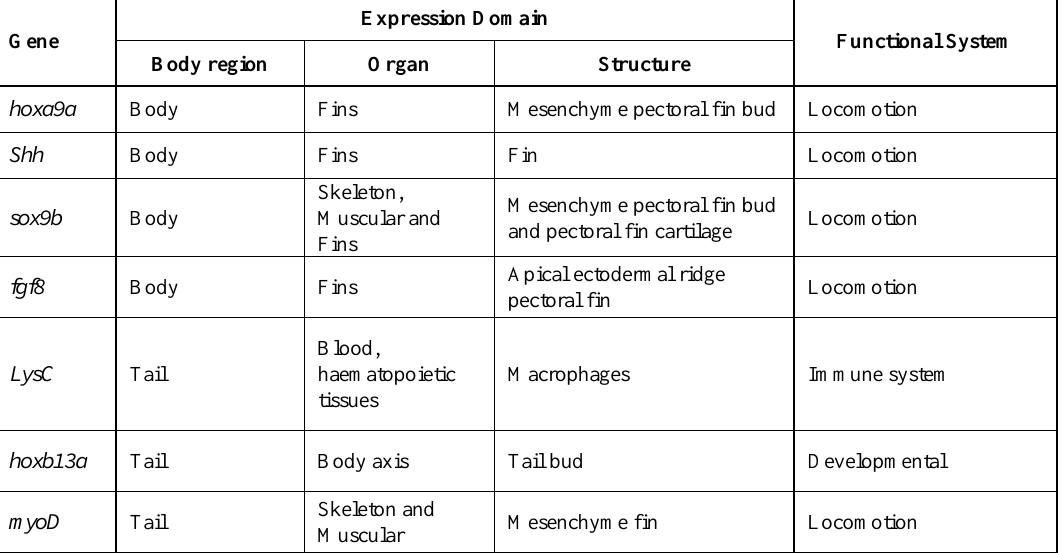
Table 5: Spatial relationships between genes of the selected patterns.